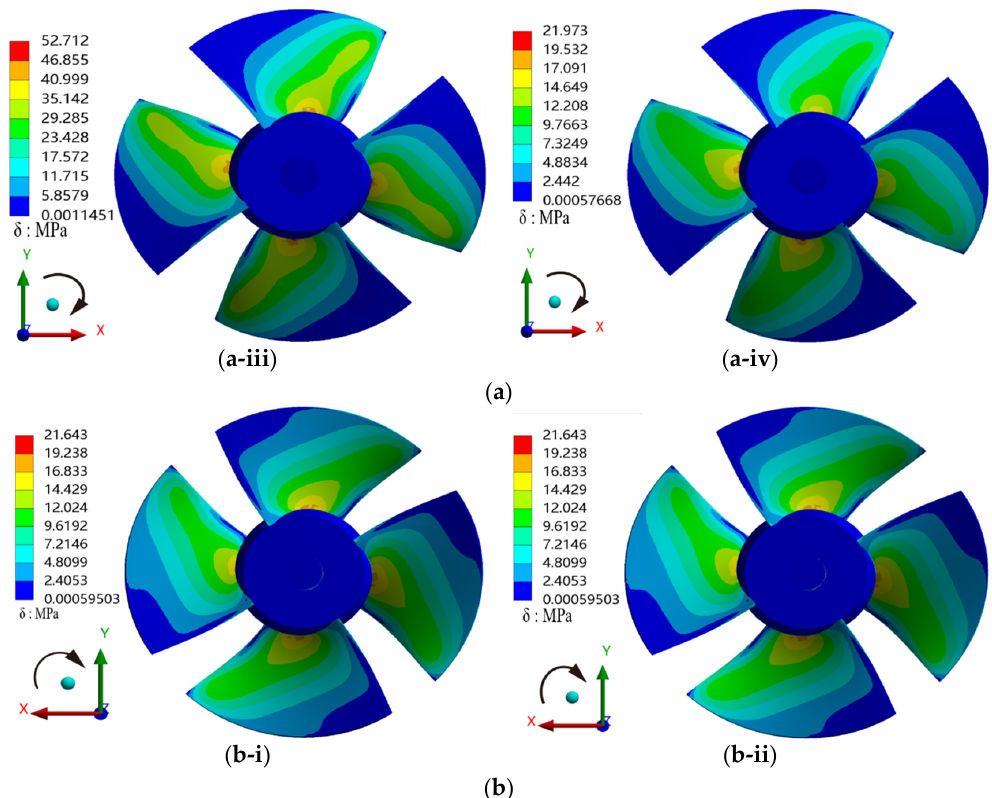
Figure 7. ( a ). Dynamic stress distribution under pump conditions. ( a-i ) 0.6 Q, ( a-ii ) 0.8 Q, ( a-iii ) 1.0 Q, ( a-iv ) 1.2 Q, ( b ). Dynamic stress distribution under turbine operating conditions. ( b-i ) 0.6 Q, ( b-ii ) 1.0 Q.